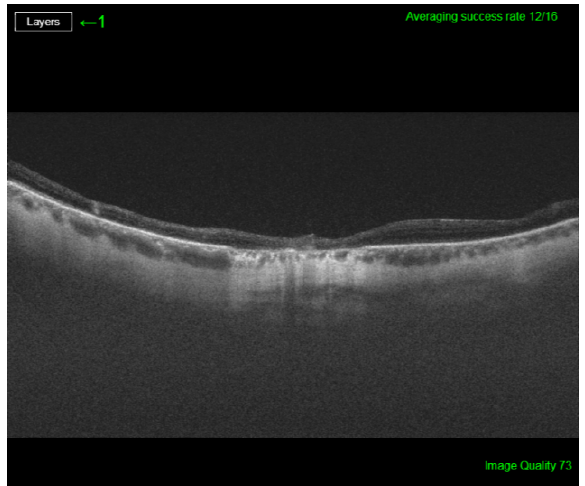
Figure 3: SS-OCT image of the right eye reveals external retina altered with an increase of choroidal signal due to retinal pigment epithelium atrophy.